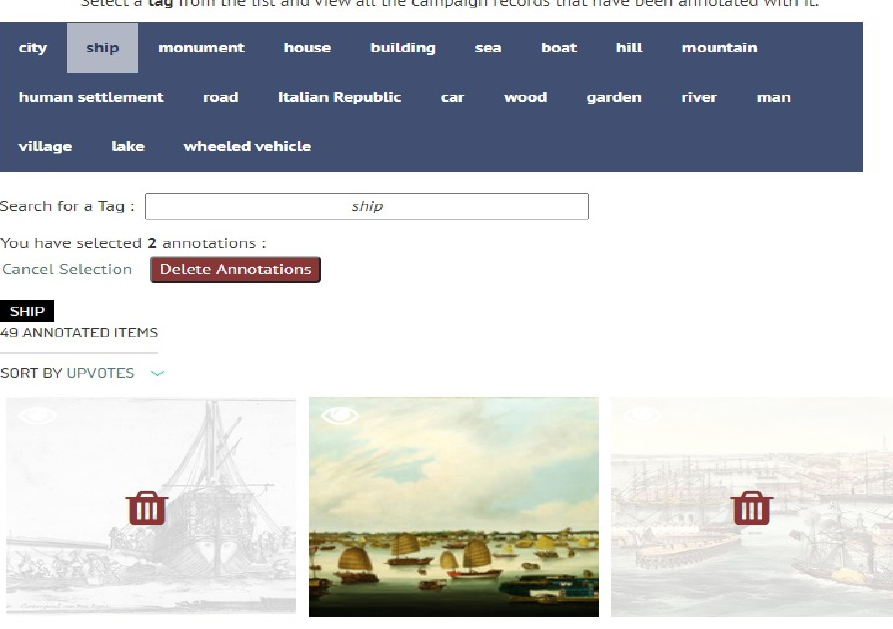
Figure 4. Validation